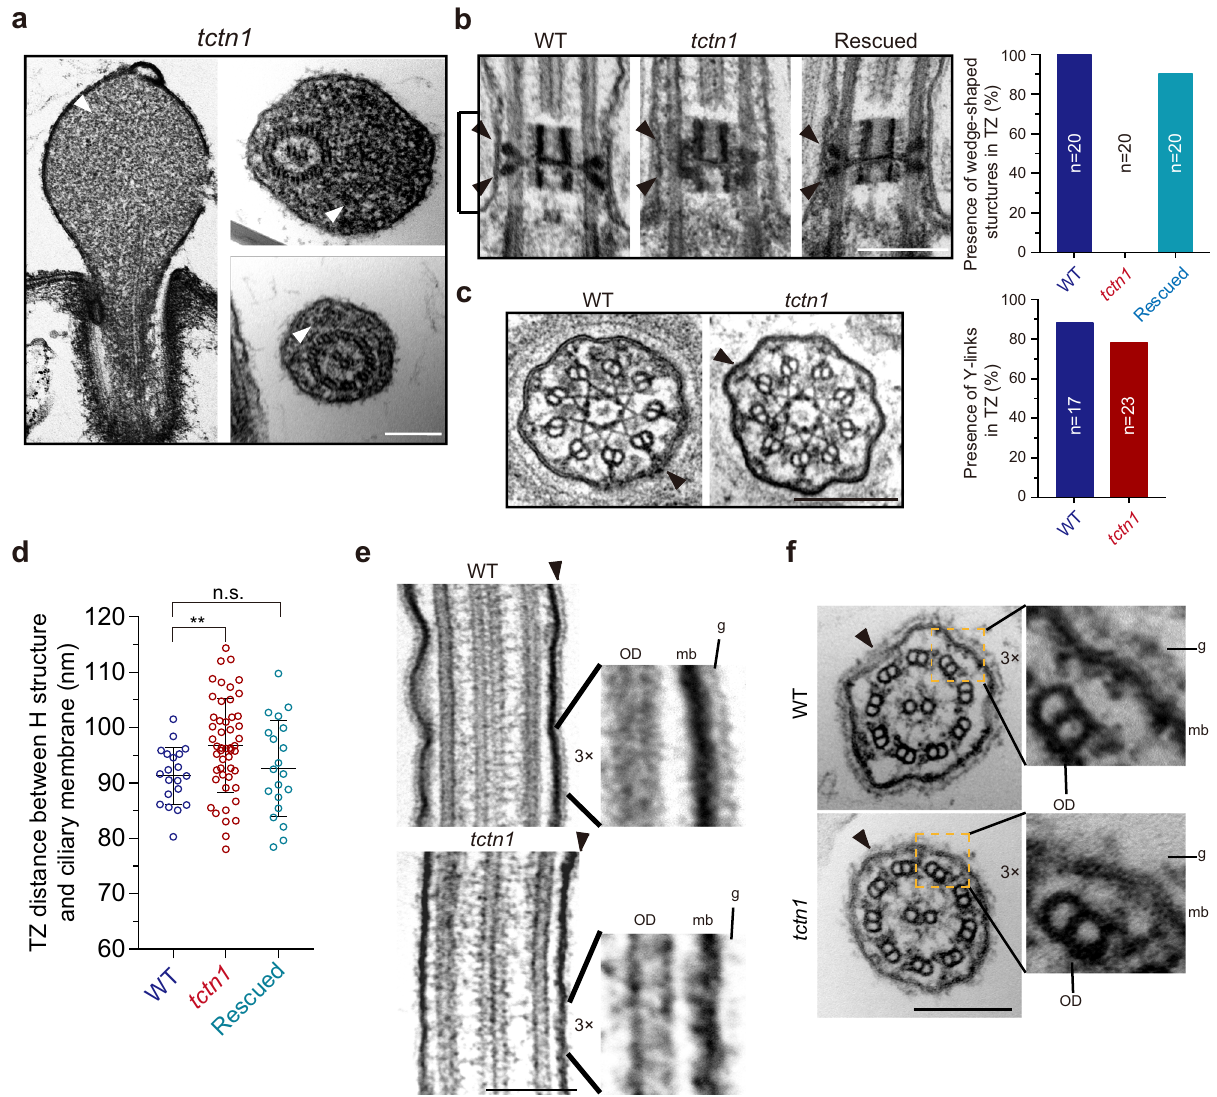
Fig. 2 Loss of TCTN1 causes ultrastructural defects of the ciliary membrane and the TZ. a EM images showing ciliary bulges with electron-dense material (white arrowheads) in a portion of tctn1 cells. Scale bar, 200 nm. b , c Longitudinal sections ( b ) and cross sections ( c ) through the TZ ( b , brackets) of WT, tctn1 and rescued cells. The wedge-shaped structures ( b , black arrowheads) and Y-links ( c , black arrowheads) were indicated. Quanti fi cation of the presence of wedge-shaped structures in the longitudinal section ( n = 20, number of wedge-shaped structures) and Y-links in the cross section ( n = 17 for WT, n = 23 for tctn1 , number represents the thin sections counted.). The presence of at least one Y-link in the thin section is considered as normal. Scale bar, 200 nm. d Scatter plot depicting the distances between the “ H ” structure and the ciliary membrane in WT, tctn1 , and rescued cells. Data are the mean ± SD ( n = 20). Statistical signi fi cance was determined with an unpaired t test. n.s., not signi fi cant; ** P < 0.01 by two tailed. e , f TEM images of longitudinal ( e ) and cross ( f ) sections of the cilia from WT and tctn1 cells. Glycocalyx on the surface of ciliary membrane was indicated with black arrowheads. The high magni fi cation regions were indicated by dotted boxes. OD outer doublet microtubule, mb ciliary membrane, g glycocalyx. Scale bar, 200 nm. Source data are provided as a Source Data fi